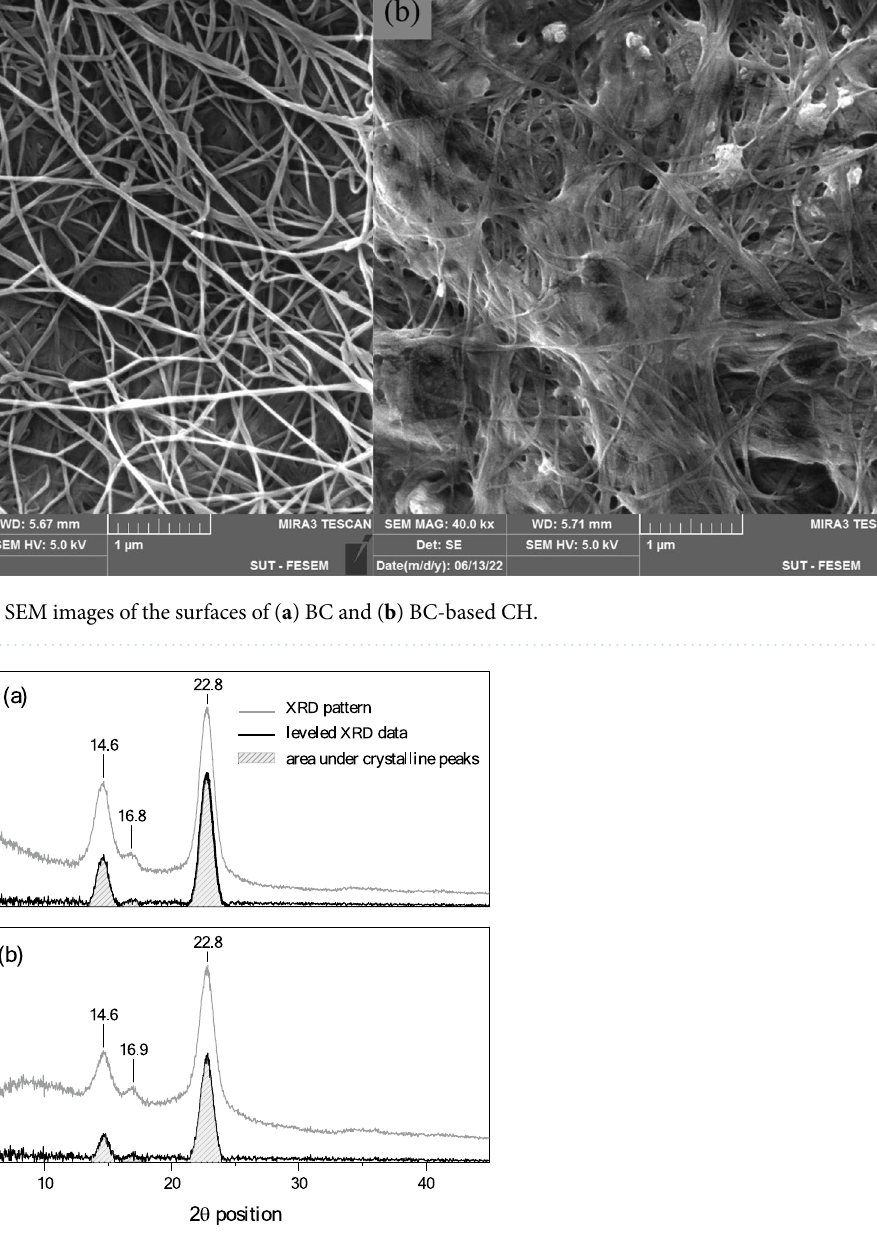
Figure 3. XRD spectra used for crystallinity index calculation (origin Pro software): ( a ) BC and ( b ) BC-based